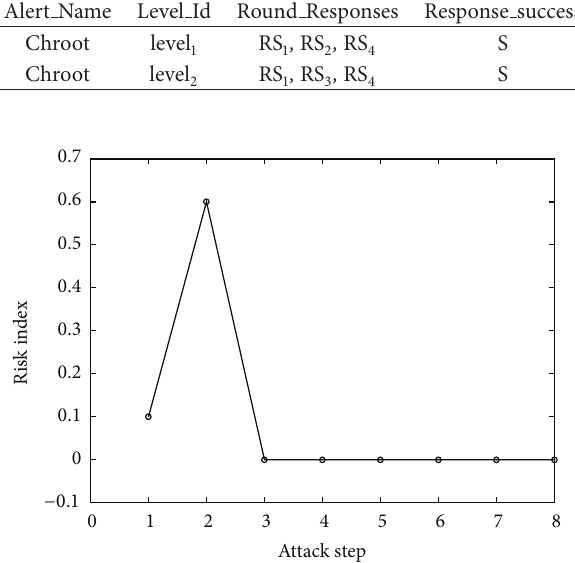
Figure 5: The online risk assessment result for escaping the chroot